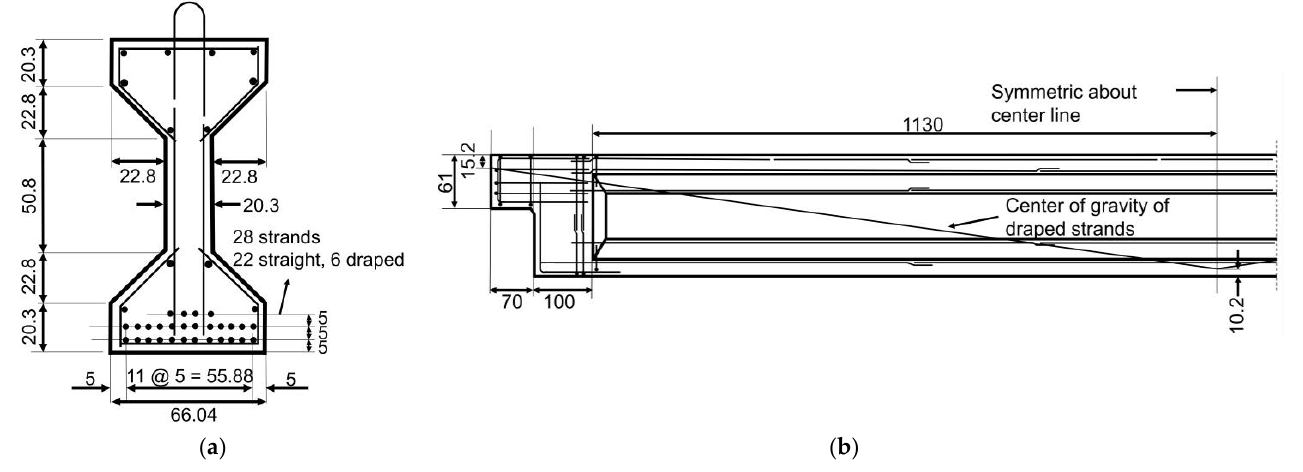
Figure 1. The testbed structure: ( a ) cross-section view of each girder and ( b ) elevation view of each girder. All the dimensions are in centimeters, and all reinforcing rebars are #4 (equivalent to Φ13).